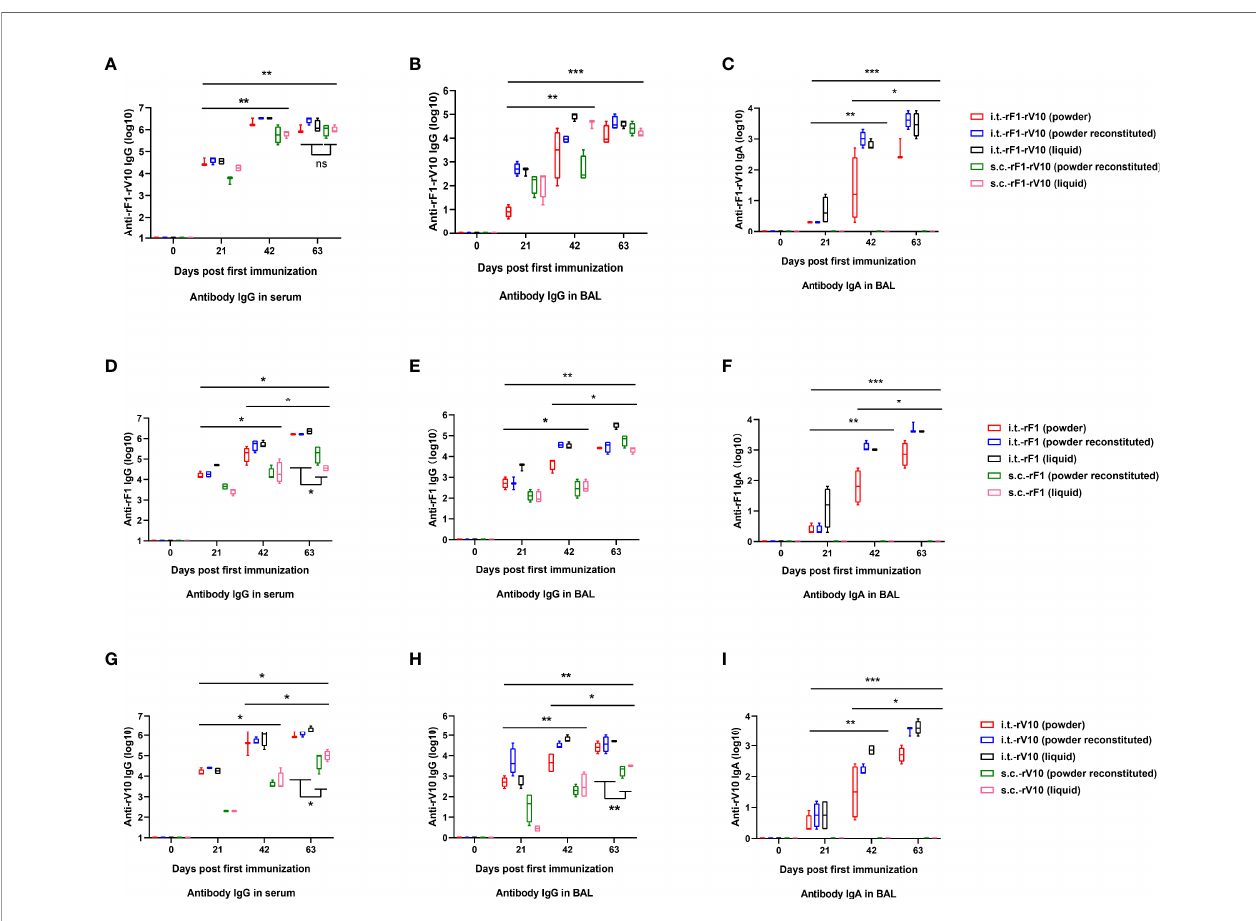
FIGURE 4 | Humoral and mucosal antibody responses (mean ± SD) in mice at 21-, 42- and 63-days post-immunization elicited by rF1-V10, rF1, and rV10 vaccines via i.t. (powder, powder reconstituted and liquid formulations) or s.c. (powder reconstituted and liquid formulations). (A, D, G) Reciprocal serum titters of IgG to (A) rF1-V10, (D) rF1, and (G) rV10. (B, E, H) Reciprocal BAL titers of IgG to (B) rF1-V10, (E) rF1, and (H) rV10. (C, F, I) Reciprocal BAL titers of IgA to (C) rF1-V10, (F) rF1, and (I) rV10. Serum and BAL were collected from four mice per group at 21, 42, and 63 dppi and titers were measured by ELISA. Statistical differences were calculated by two-way ANOVA, followed by least signi fi cant difference (LSD) analysis or Tukey ’ s test. * P < 0.05; ** P < 0.01; *** P <